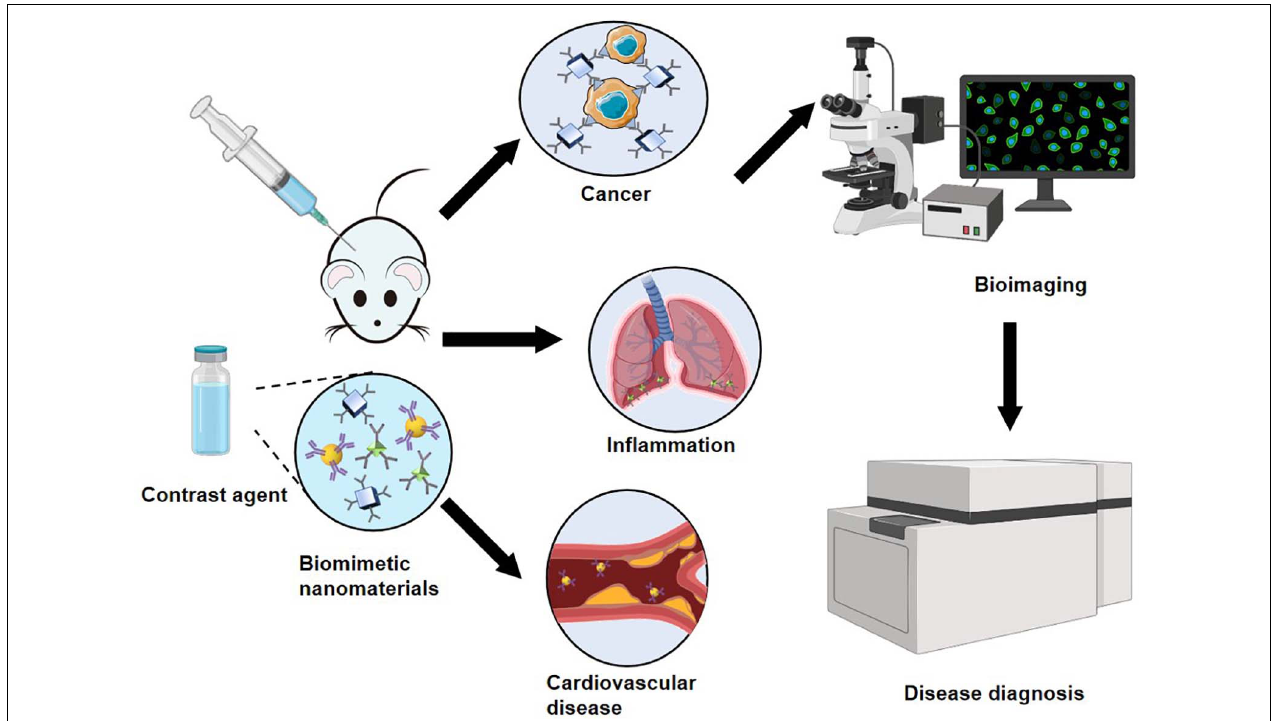
FIGURE 3 | Schematic diagram of biomimetic nanomaterials applied to